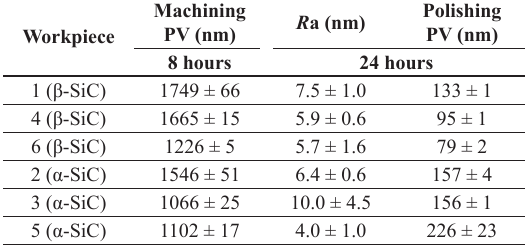
Table 6. Peak-to-valley deviations after 8 hour machining, and finished surface R a roughness, and peak-to-valley deviations after 24 hours polishing.